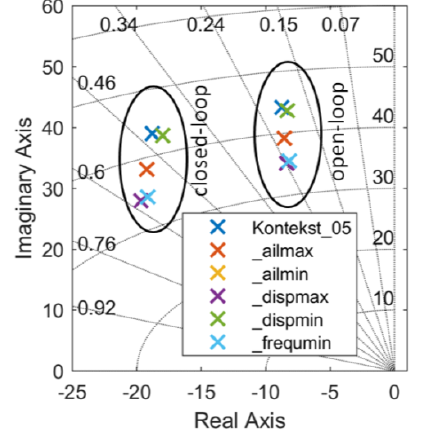
Figure 14. Comparison of open- and closed-loop poles of the first wing bending mode of the different aeroelastic models.